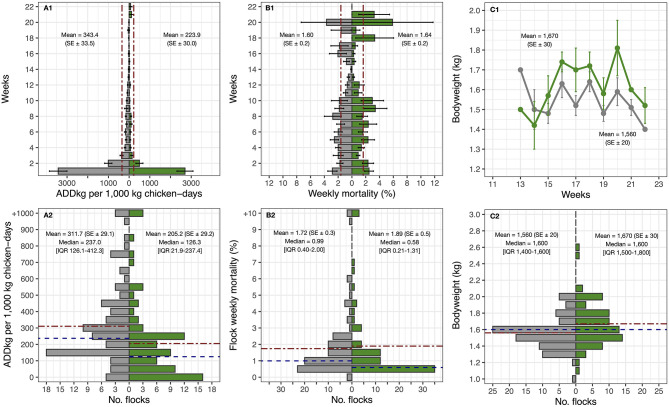
Comparisons between AMU, mortality and bodyweight by weeks and flocks between baseline (in gray color) and intervention phase (in green color) in 31 eligible farms. Dot-dash red line: Mean. Dashed blue line: Median.